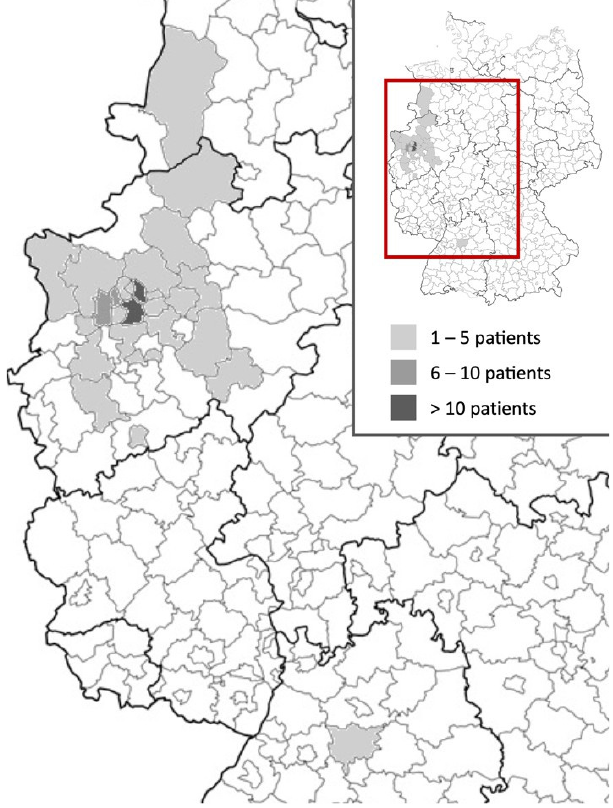
Figure 3. Heat map of referral areas of children and adolescents attended at the Long COVID Outpatient Department of the University Hospital Essen between January 2021 and September 2022 with suspected Long COVID. 16 (15%) patients had been vaccinated against SARS-CoV-2 (Table 1). Except for pa-